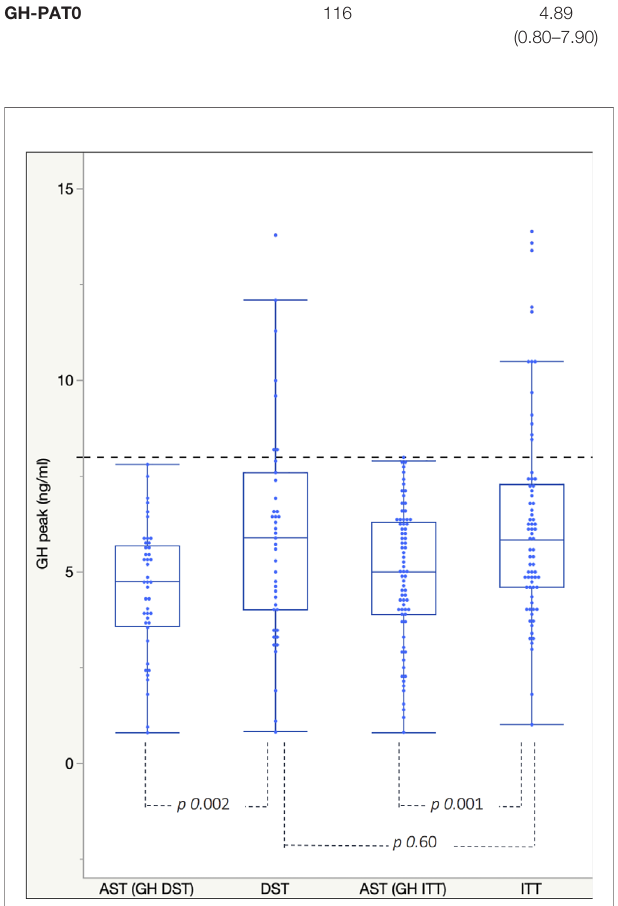
FIGURE 2 | Box plots for mean and interquartile range of GH peaks achieved after AST and ITT / DST in the GH-PAT0 ITT and GH-PAT0 DST subgroups. The dotted blue line represents the cut-off of 8 ng/ml used to discriminate between GH de fi cient and not-de fi cient